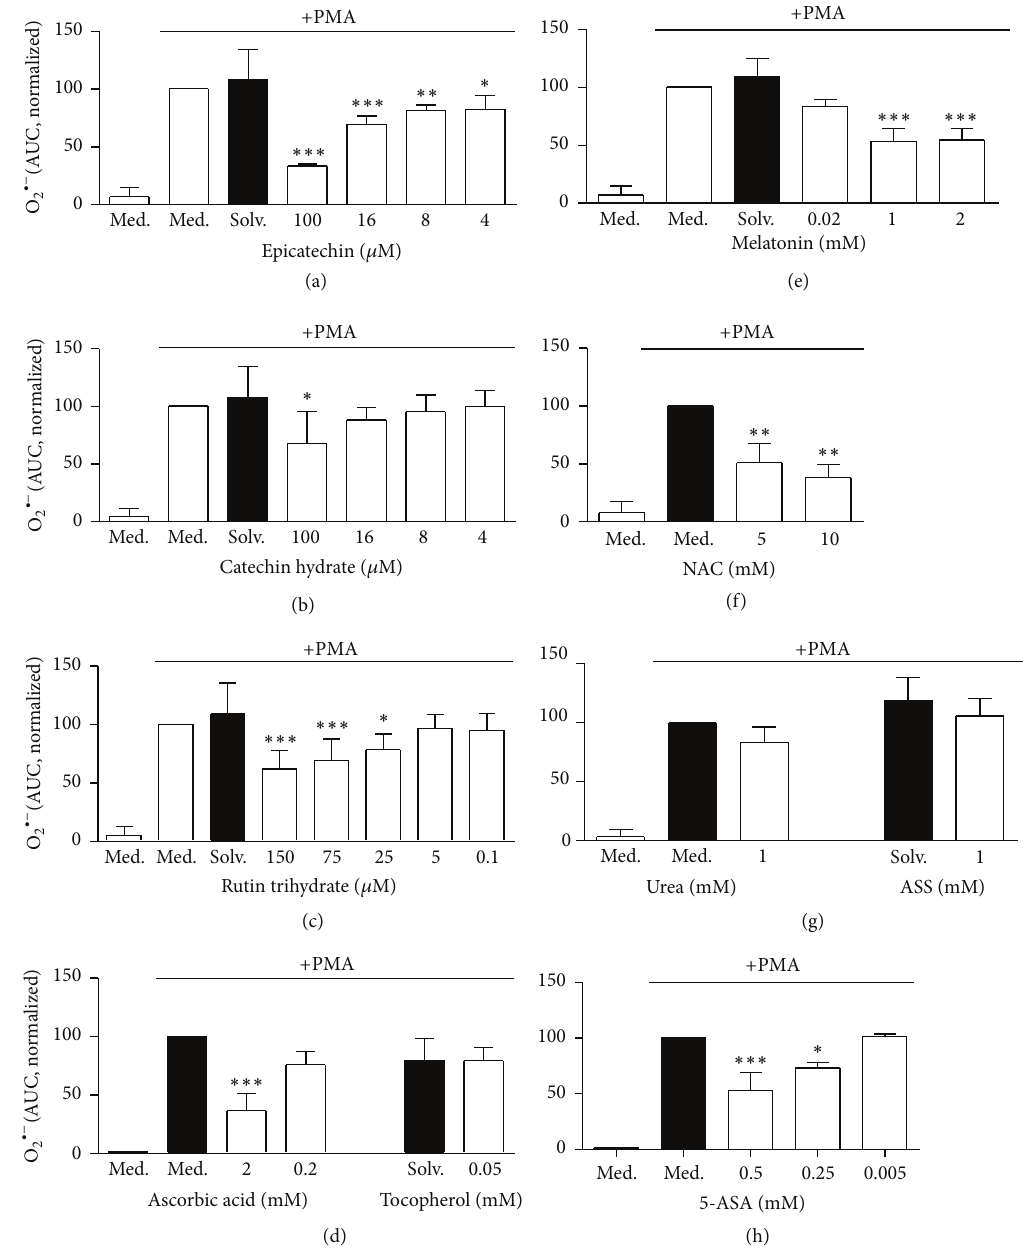
Figure 3: Influence of antioxidants on extracellular ROS formation of neutrophils as measured by the lucigenin assay. Neutrophils were preincubated with or without antioxidants for 30 min at 37 ∘ C. Following addition of lucigenin (0.2mM), ROS formation was induced by 20 nM PMA and the kinetic of O 2∙− -formation was measured over a period of 1 h at 37 ∘ C. O 2∙− -formation of (a) epicatechin, (b) catechin hydrate, (c) rutin trihydrate, (d) ascorbic acid and tocopherol, (e) melatonin, (f) N -acetyl-L-cytseine (NAC), (g) urea and actetylsalicylic acid (ASS), and (h) 5-aminosalicylic acid (5-ASA) was quantified by calculation of the area under the curve (AUC). Data were normalized to the sample of PMA-stimulated neutrophils without antioxidants (Med.). Data show mean ± SD from 3 ((d), (f), (g) (urea)), 5 ((a), (e), (g) (ASS), (h)), 6 (c) or 7 (b) independent experiments with 2 ((g), ASS), 3 ( (a), (d), (e), (f), (g) (urea)), 4 (b) and 5 ((c), (h)) different donors. ∗∗∗ 𝑃 < 0.001 ; ∗∗ 𝑃 < 0.01 ; ∗ 𝑃 < 0.05 as compared to the PMA-stimulated medium or solvent control (Med., Solv., black